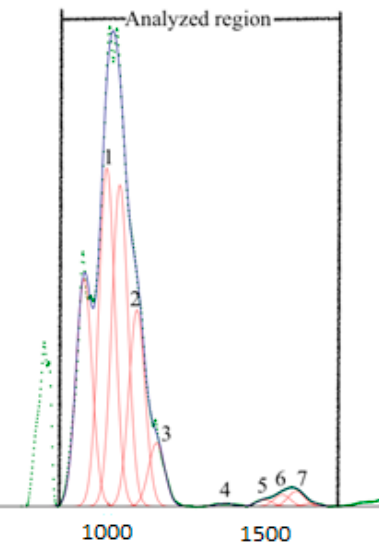
Figure 1. A representative ATR-FTIR spectra of whole soils showing the fitted Gaussian peaks representing the major C functional groups within the wavenumber range of 900–1800 cm − 1 . Peaks are identified as follows: 1—1000 cm − 1 , 2—1100 cm − 1 , 3—1160 cm − 1 , 4—1430 cm − 1 , 5—1540 cm − 1 , 6—1600 cm − 1 , 7—1640 cm − 1 .